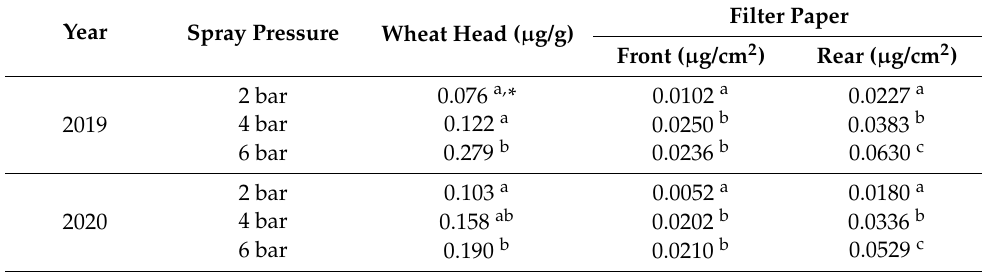
Table 2. Tracer deposit on wheat heads and on filter